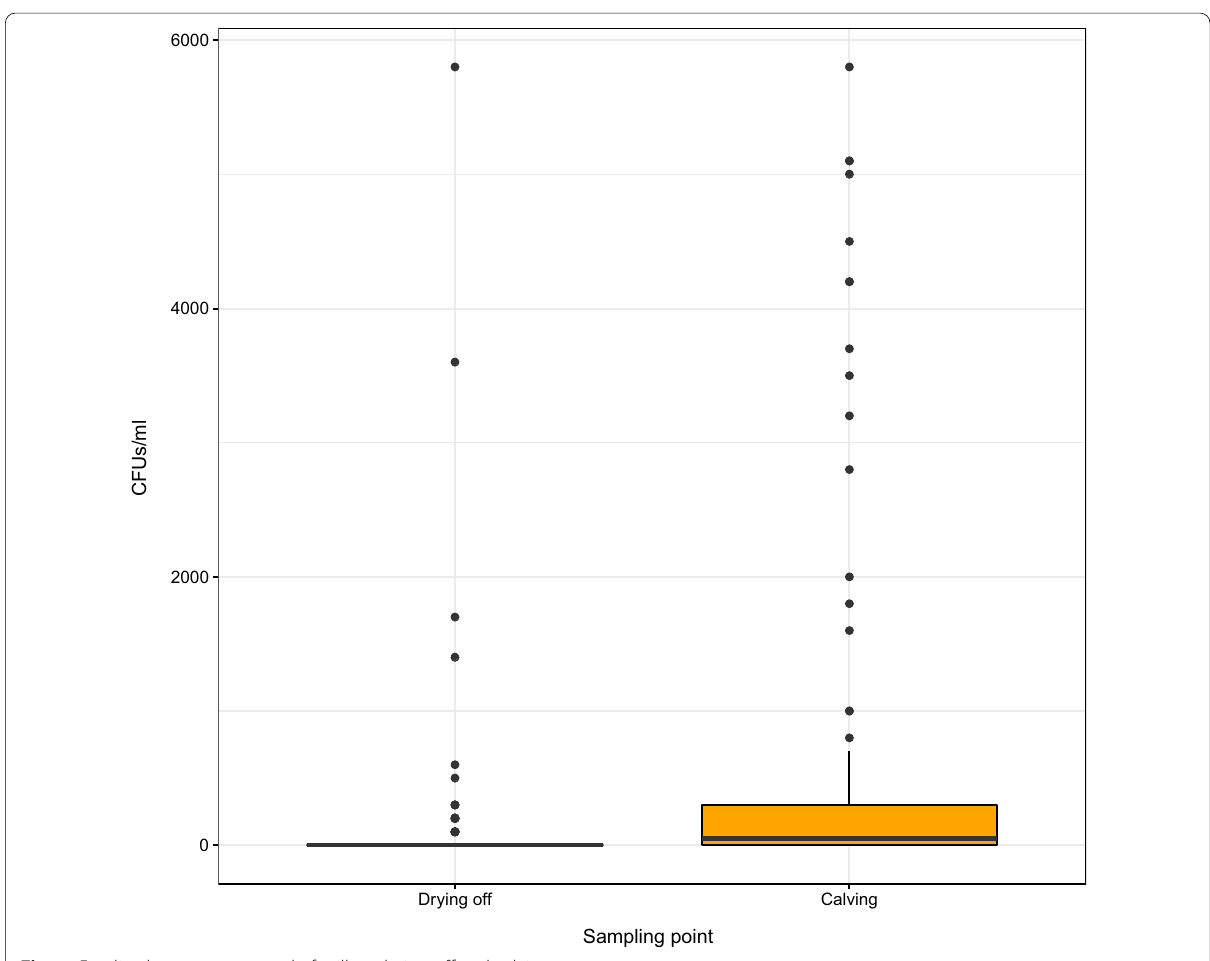
Fig. 5 E. coli colony counts per ml of milk at drying off and